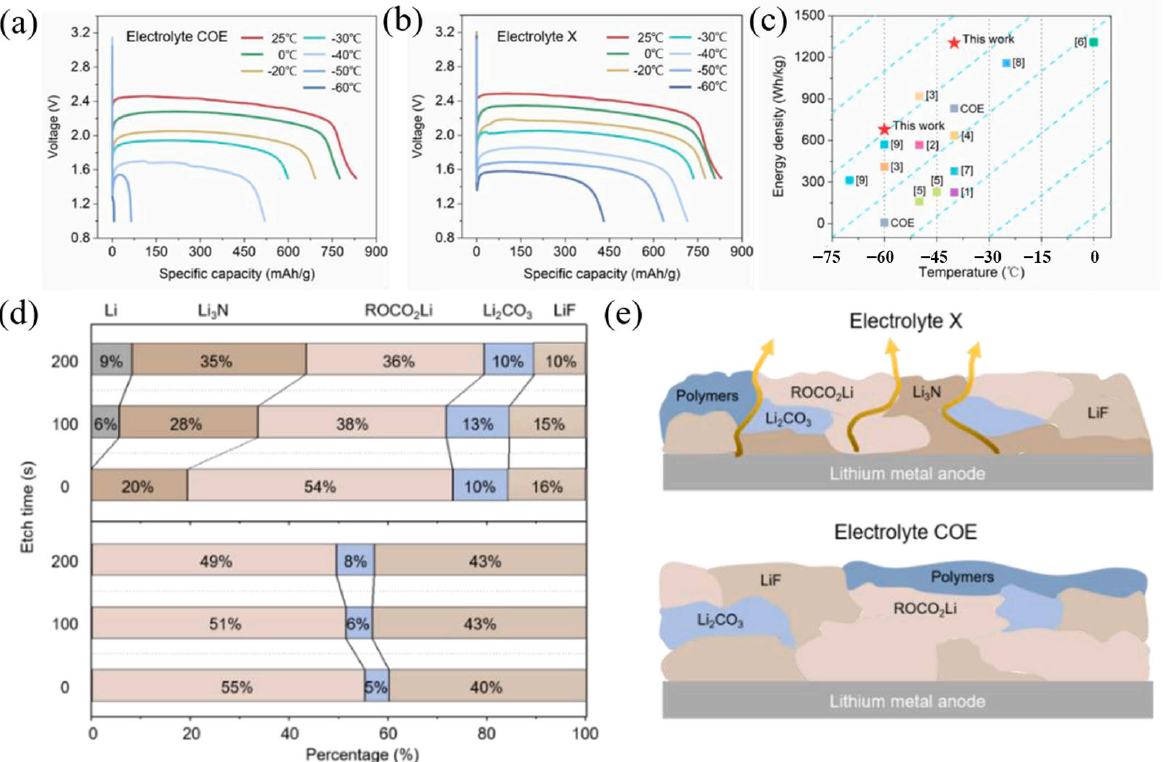
Figure 2. Discharge curves of Li/CFx primary cells using the ( a ) electrolyte COE and ( b ) electrolyte X at different temperatures (0.1 C). ( c ) The comparison with the same type of research on the energy densities of Li/CFx cells available at different temperatures. ( d ) The relative contents of lithium- containing components and ( e ) schematic diagrams of the compositions of SEI formed in the two electrolytes. ( a – e ) Reproduced with permission from [31].